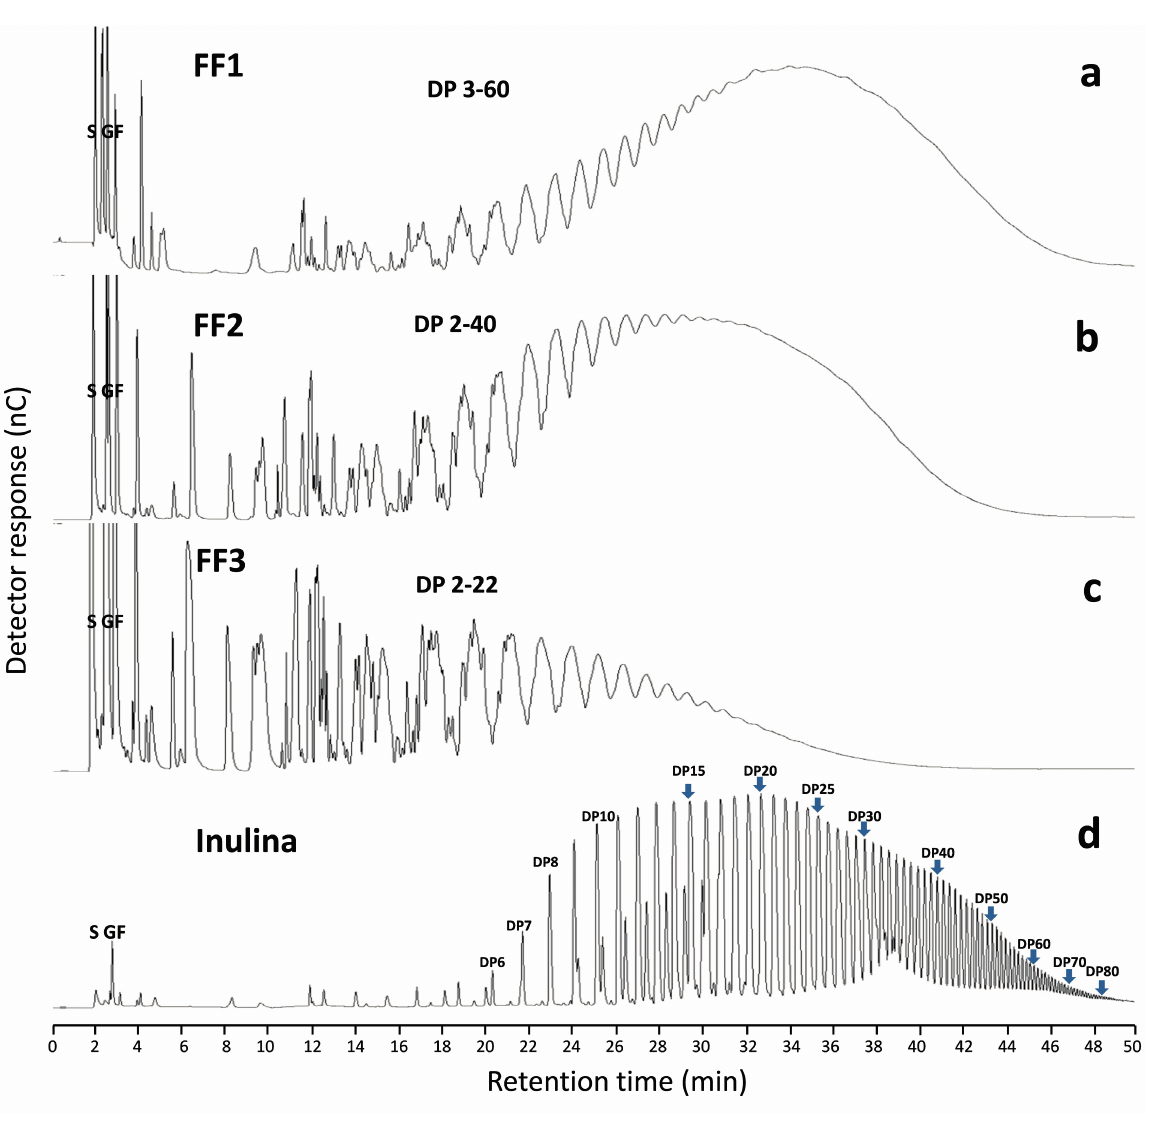
Figure 2. HPAEC-PAD chromatogram profiles. ( a ) AFF1, ( b ) AFF2, ( c ) AFF3, and ( d ) inulin profile. S, G and F refer to sucrose, glucose and fructose,